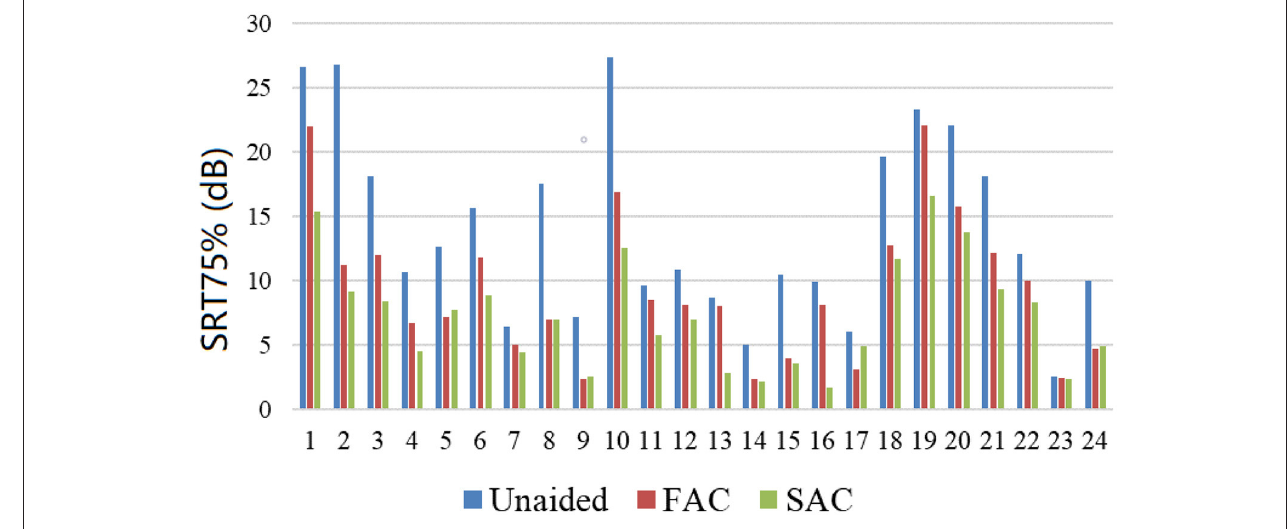
FIGURE 5 | SRT75% measured across